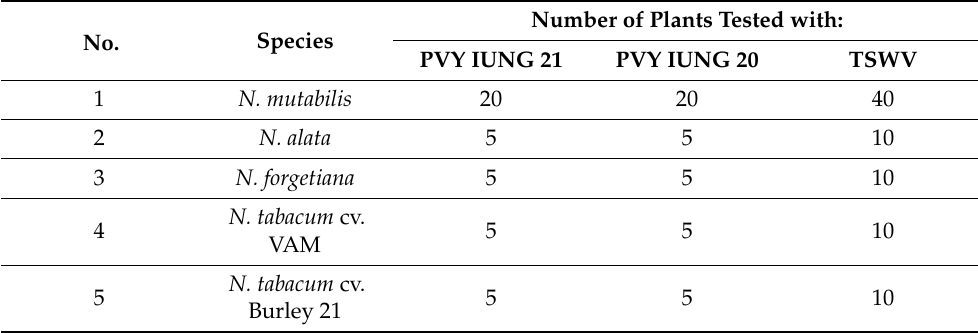
Table 1. Species tested for resistance to PVY and TSWV, as well as the presence of molecular markers. Number of Plants Tested with: No. Species PVY IUNG 21 PVY IUNG 20 TSWV 1 N. mutabilis N. alata N. forgetiana N. tabacum cv. VAM N. tabacum cv. Burley